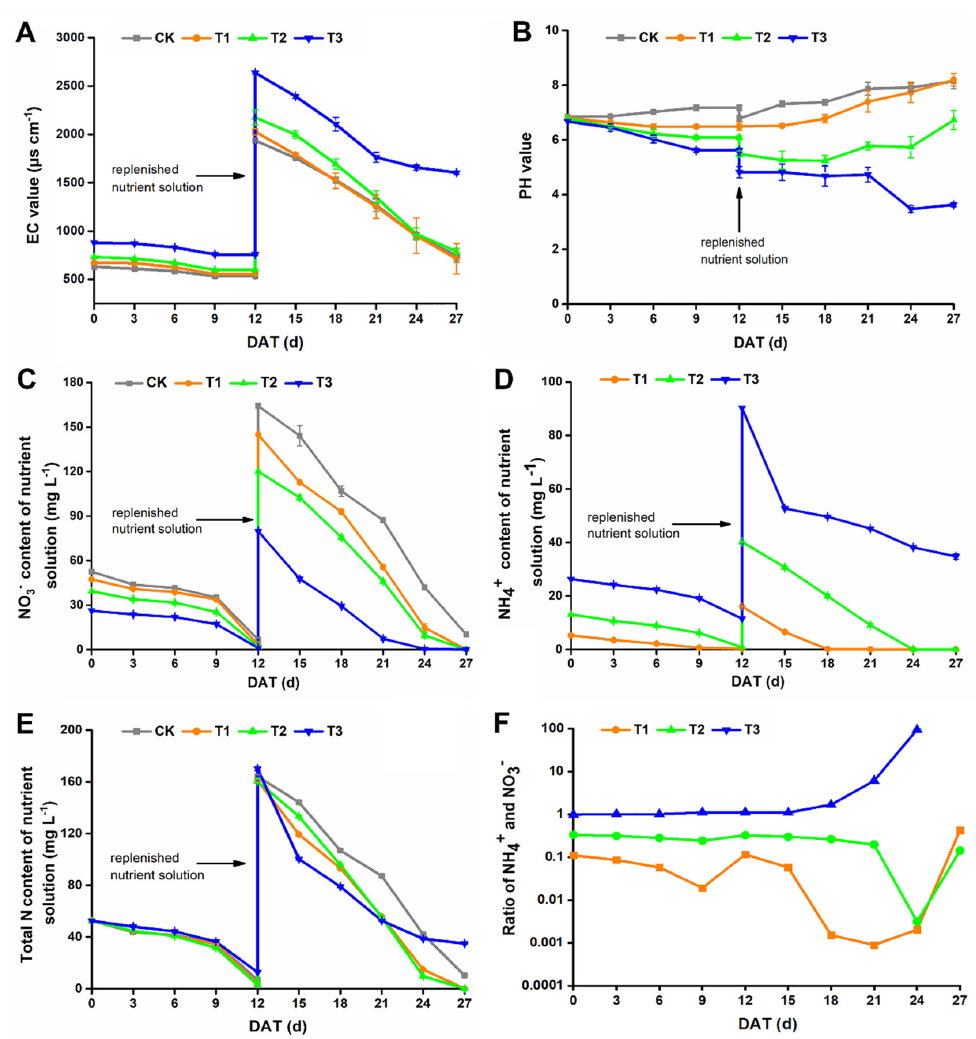
Figure 2. Changes in electrical conductivity value ( A ), pH value ( B ), NO 3 − content ( C ), NH 4+ content ( D ), total N content ( E ), and NH 4+ /NO 3 − ratios ( F ) in nutrient solution under different NH 4+ /NO 3 − ratios. CK = 0/100, T1 = 10/90, T2 = 25/75, T3 = 50/50. DAT, days after treatment. The data represent mean ± SE ( n =